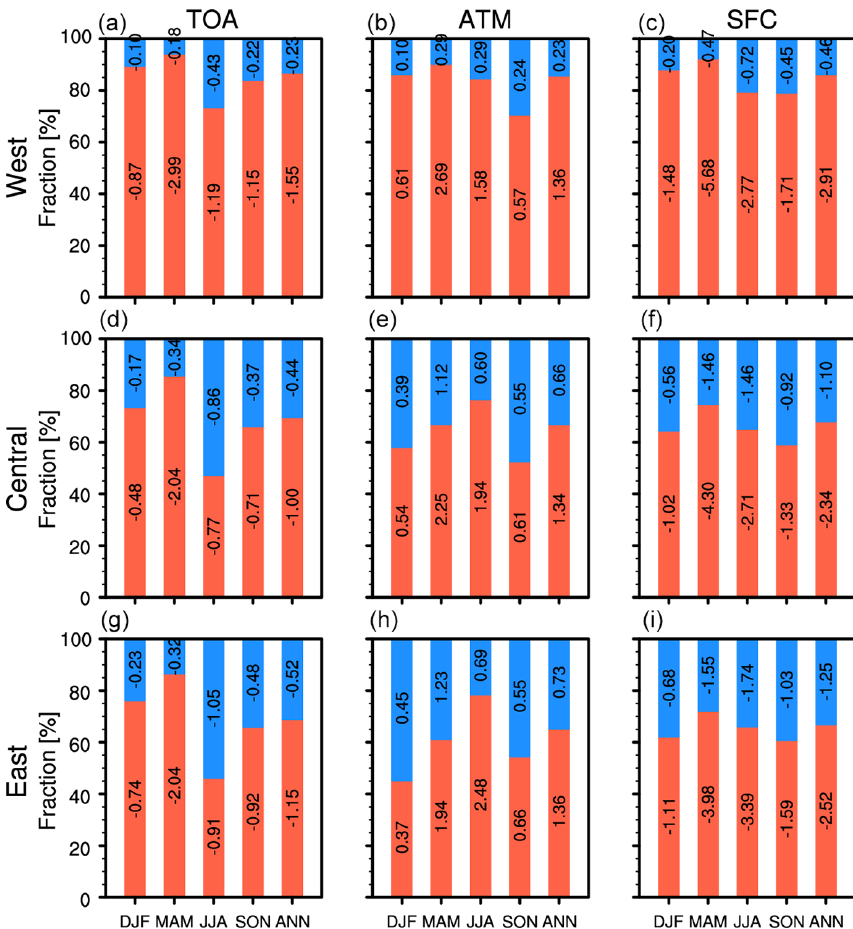
Figure 15. Seasonal and annual variation of radiative forcing fraction at the TOA (a, d, g) , in the atmosphere (b, e, h) , and at the surface (c, f, i) from trans-Pacific transport (red) and US (blue) aerosols in western, central, and eastern North America for